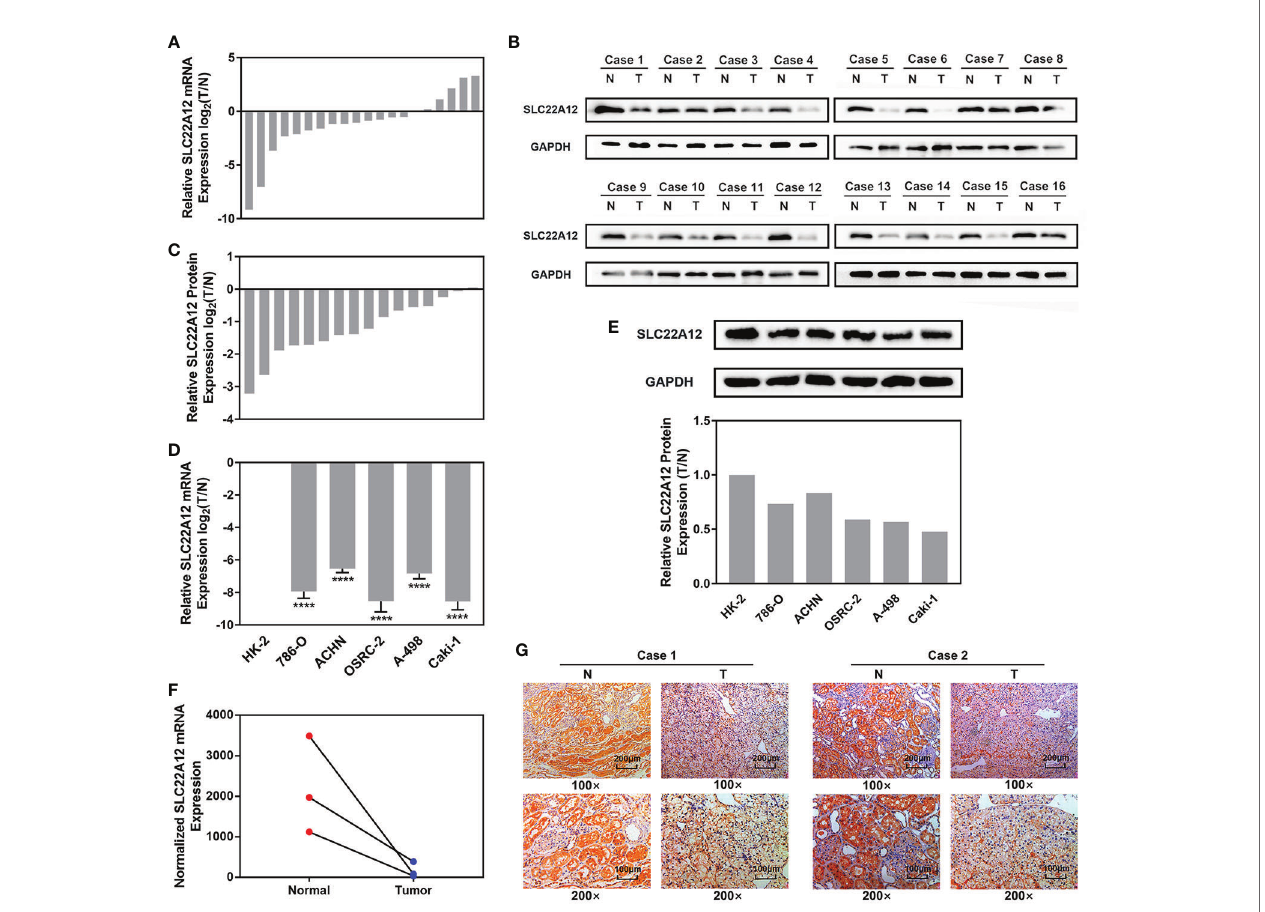
FIGURE 5 | SLC22A12 was down-regulated in RCC cells and tissues compared to their corresponding control. Relative mRNA expression of SLC22A12 was lower in RCC (A) tissues and (D) cells than their normal control measured by qRT-PCR assays. Relative protein expression of SLC22A12 was lower in RCC (B, C) tissues and (E) cells than their normal control measured by immunoblotting tests. (F) Transcriptomic levels of SLC22A12 in normal and tumoral tissues gathered from Wuhan Union Hospital ’ s cohort. (G) Representative images of immunohistochemical analyses suggested a lower SLC22A12 expression in tumoral tissue. ****p <